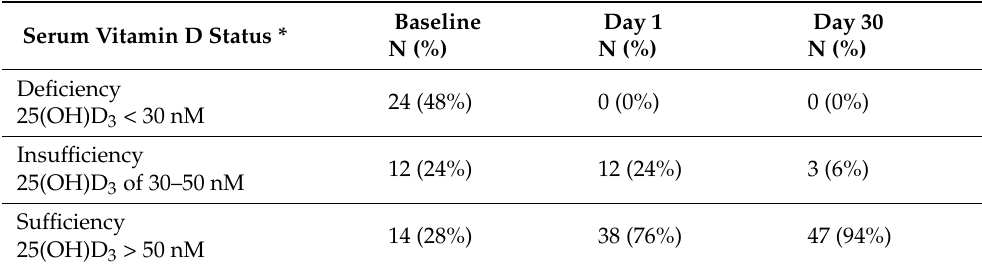
Table 2. Prevalence of vitamin D deficiency among study participants at baseline, day 1 and day 30 following a single high dose of vitamin D 3 supplementation (n = 50).